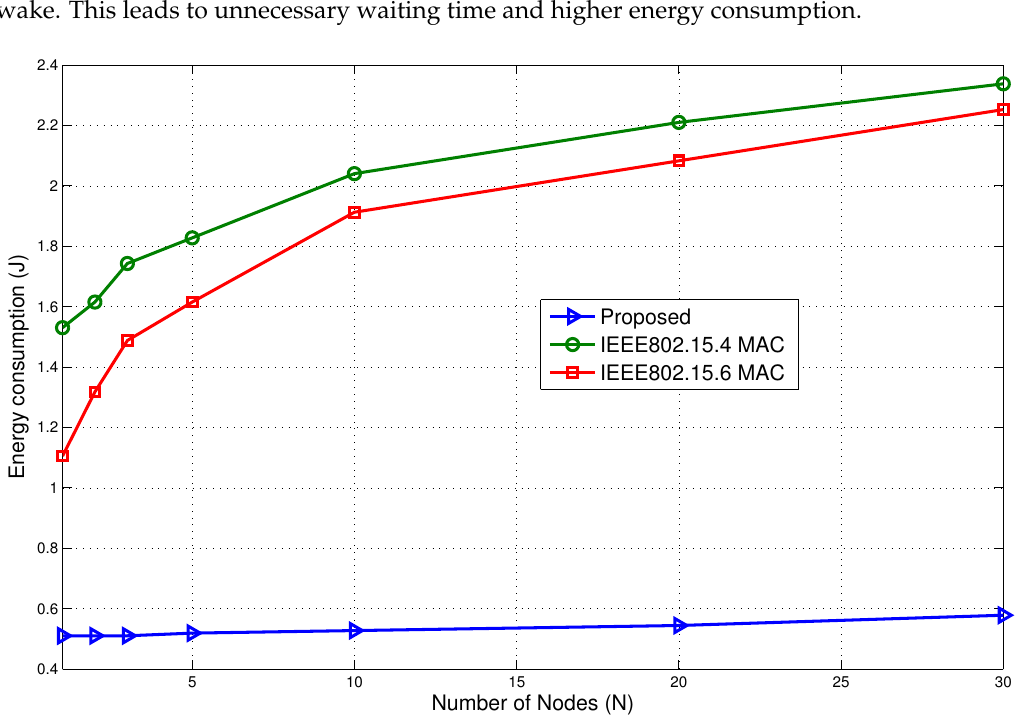
Figure 25. Energy consumption comparison with standard